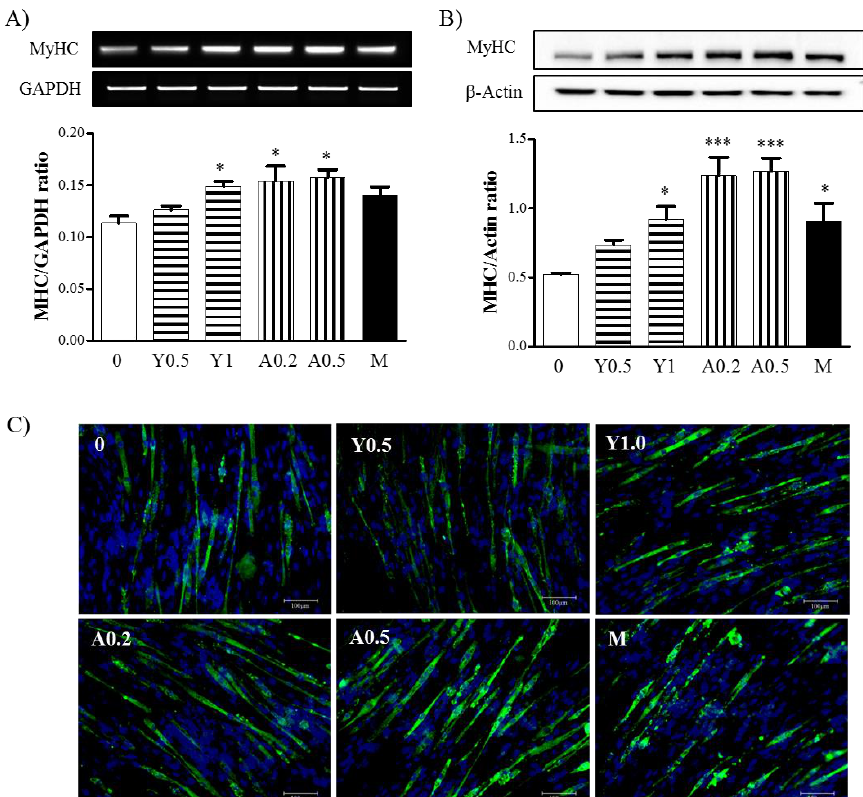
Figure 1. Effects of yam extract and allantoin on the expression of MyHC protein and mRNA in C2C12 myotubes. C2C12 myoblasts were differentiated with DMEM containing 2% HS for 5 days, then treated with or without yam extract (0.5 and 1.0 mg/mL) or allantoin (0.2 and 0.5 mM) for 24 h. Metformin (2.5 mM) was used as a positive control. The expression of MyHC mRNA ( A ) and protein ( B ) was determined by RT-PCR and western blot, respectively. GAPDH and β -actin were used as internal controls. All data were presented as the means ± SEM of three independent experiments. Y, yam extract; A, allantoin; and M, metformin. * p < 0.05 and *** p < 0.001 vs. non-treated cells; ( C ) the myotubes were stained with anti-MyHC antibody and DAPI, then observed by fluorescence microscopy (original magnification = 200×). Green, MyHC -positive cells; and blue, DAPI-positive nuclei.